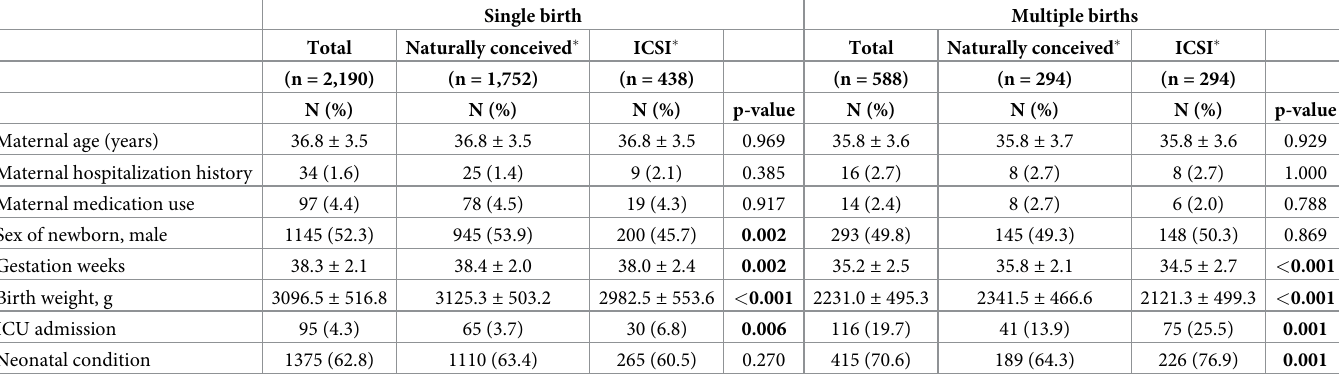
icantly higher in the ICSI group than in the natural-conception group (76.7% vs 70.4%, Table 2). After 1:1 PSM was used to match the characteristics of the pregnant women in the Table 3. Matched characteristics of pregnant women and newborns for patients with single and multiple births.